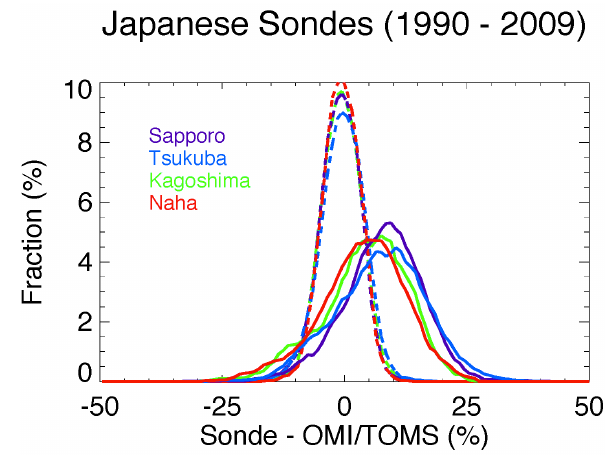
Figure 1. A comparison of column ozone between integrated ozonesonde profiles from and the TOMS/OMI overpass data for the four Japanese stations. The thick lines represent data without the CF, while the dashed lines represent the data multiplied by the CF as applied and cited in the WOUDC data files. Kagoshima data cease in 2005.